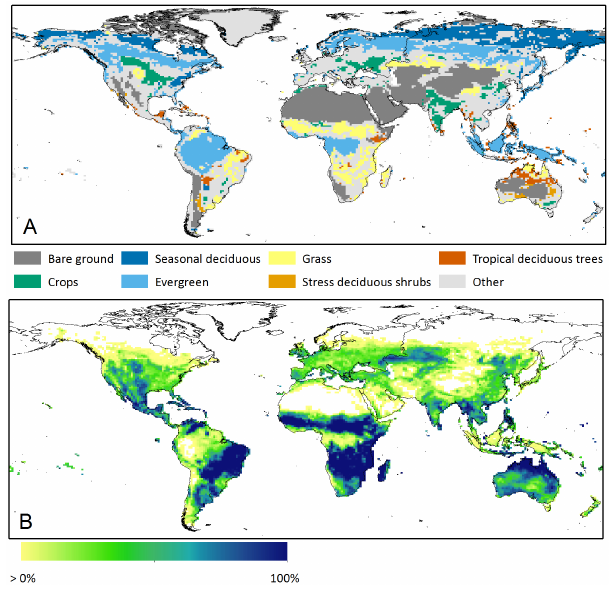
Figure 1. (a) Areas of the globe dominated by a single PFT (>50%) grouped where appropriate (e.g., there are actually three grass PFTs). (b) Percent cover of drought deciduous PFTs within the nat- ural vegetation component of each grid cell; gray areas have zero percent cover of drought deciduous vegetation. For visual clarity, grid cells with <50% natural vegetation (e.g., grid cells that are mostly water) are not shown in both